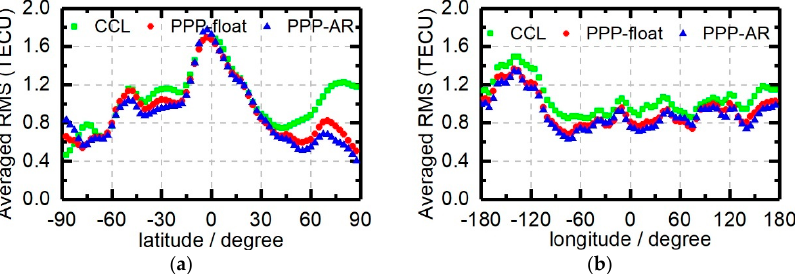
Figure 11. Latitude-dependent averaged RMS distributions ( a ) and longitude-dependent averaged RMS distributions ( b ) for the CCL, PPP-float, and PPP-AR methods compared with CODE final GIM products on DOY 100, 2017.